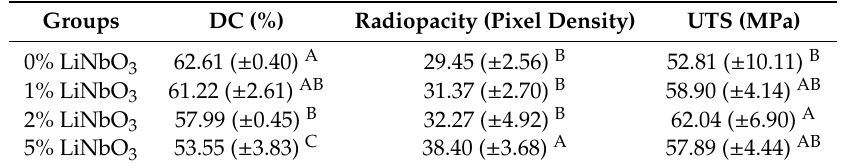
Table 1. Results of the degree of conversion (DC), radiopacity, and ultimate tensile strength (UTS) of the experimental adhesives expressed in the mean and standard deviation for each